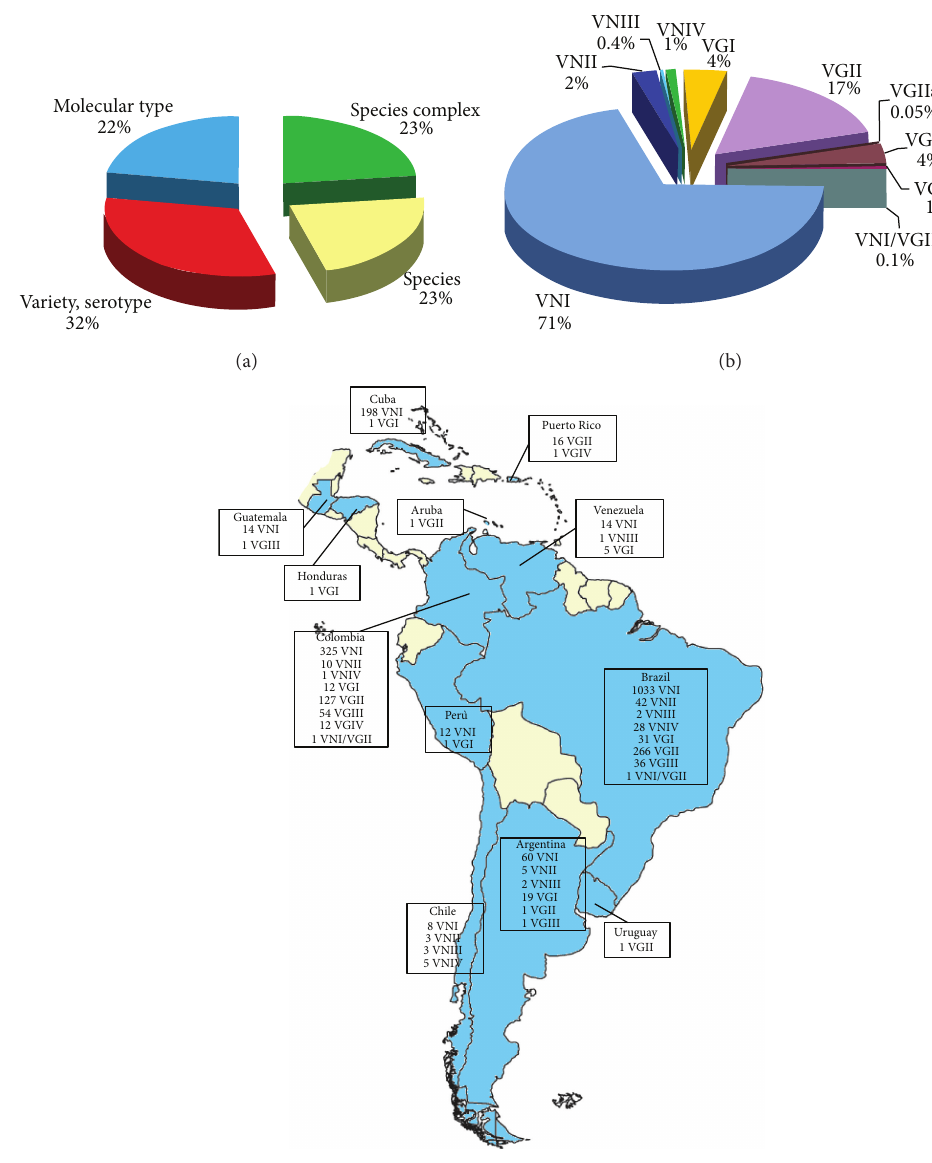
F 10: Percentage of Cryptococcus neoformans and Cryptococcus gattii isolates ( variety�serotype, or molecular type level (a). Prevalence of the di�erent VN and VG molecular types among the isolates identi�ed at molecular type level ( ,345) (b). Geographic distribution of the molecular types identi�ed in Central and �outh America (c). Molecular 𝑛𝑛 𝑛 𝑛